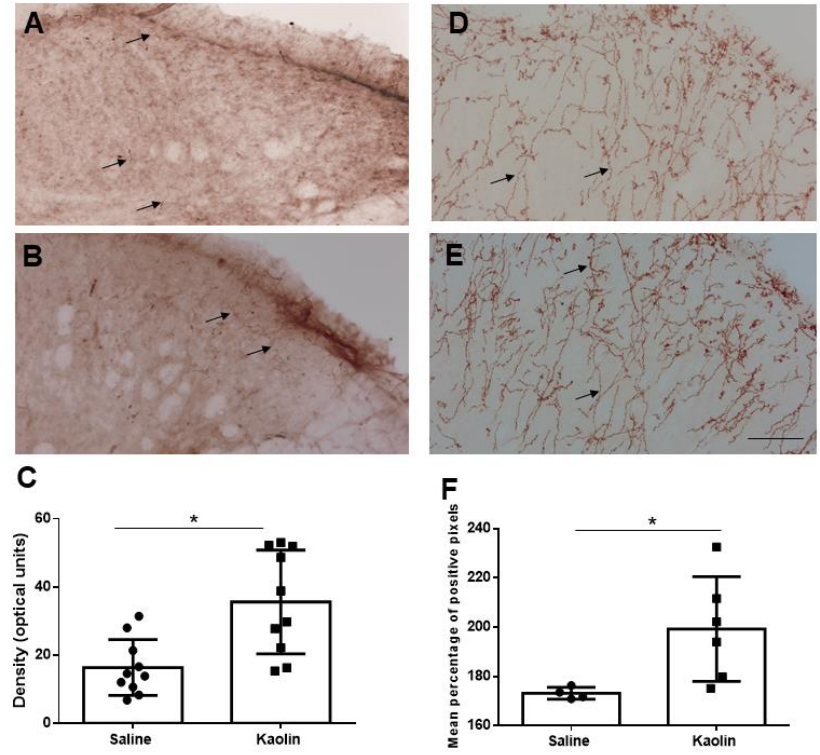
Figure 3. Immunohistochemical analysis of TH ( A – C ) and DBH ( D – F ) expression at the spinal dorsal horn in animals injected with saline ( A , D ) or kaolin ( B , E ). Representative photomicrographs of TH- and DBH-immunolabelling at the spinal dorsal horn are shown and the details of the immunoreactivity are pointed by the arrows, namely fibers with some varicosities. Kaolin-injected animals presented increases in TH ( C ) and DBH ( F ) expression in the spinal dorsal horn. For TH: Saline n = 10; Kaolin n = 10. For DBH: Saline: 4; Kaolin = 6. Scale bar in A: 100 µm; ( A , B , D , E ) are at the same magnification. Data in ( C , F ) are presented as means ± SEM. * p < 0.05.